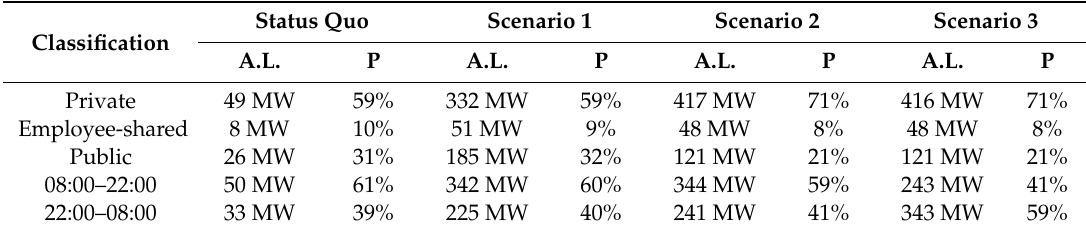
Table 2. Key parameters of di ff erent